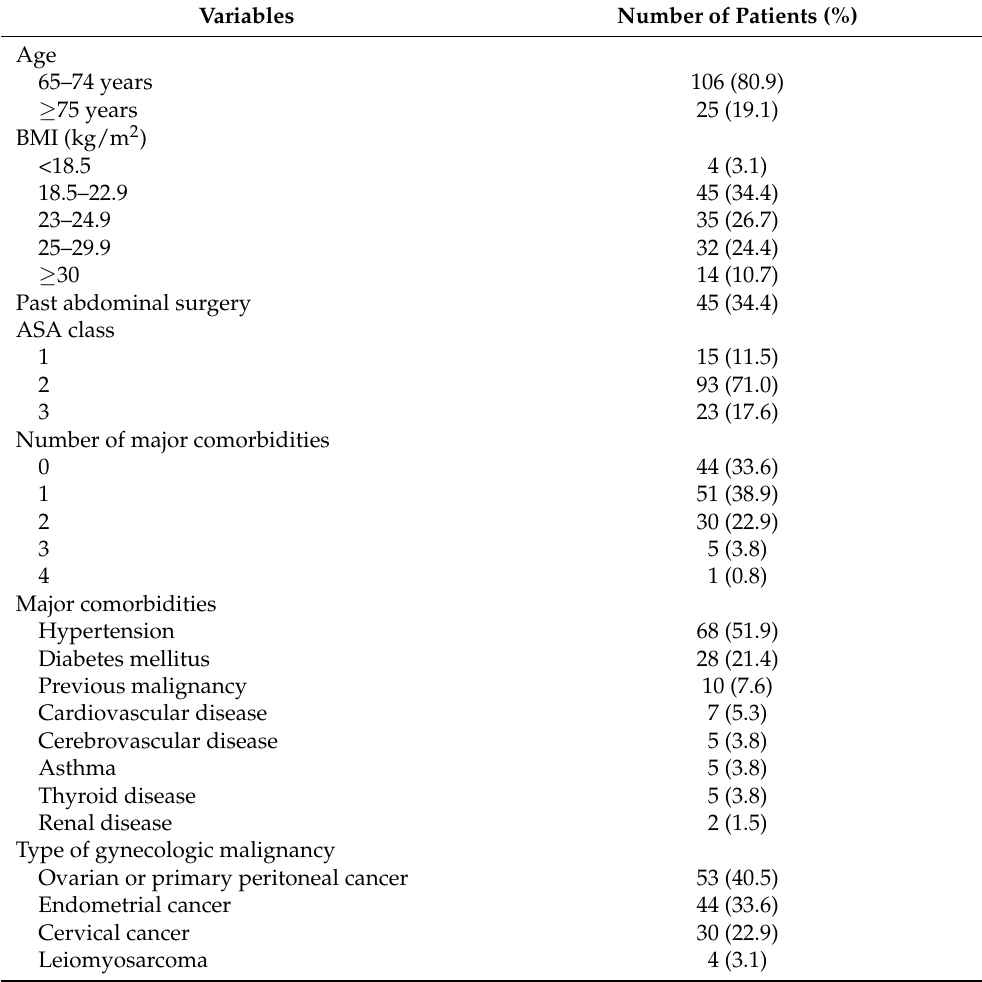
Table 1. Preoperative characteristics ( n =